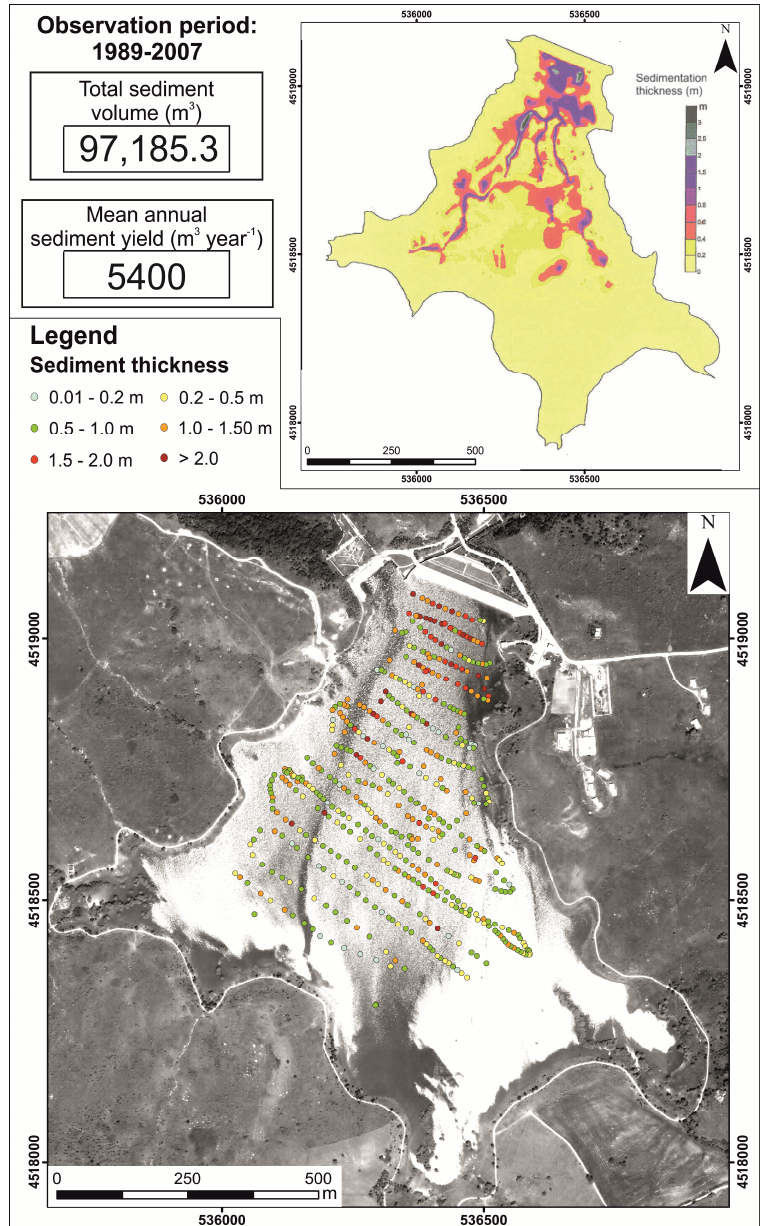
Figure 5. Bathymetric survey carried out 18 years after the building of the dam. Sedimentation volume has been reconstructed by comparing a pre-dam topography (year: 1987) with the interpolated map of the sediment thickness deriving from the results of the bathymetric survey (September 2007).